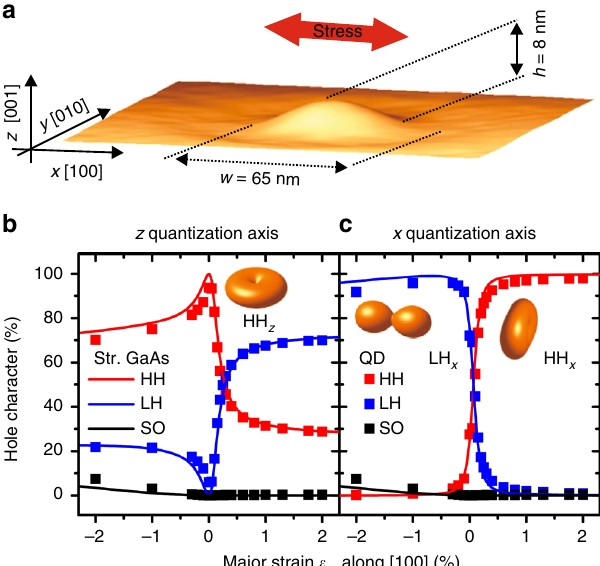
Fig. 1 Illustration of the concept used to rotate the natural quantization axis of an epitaxial QD. a 3D view of an AFM image of a GaAs QD embedded in AlGaAs matrix. b , c Calculated effect of uniaxial stress along the [100] crystal direction on the degree of mixing of the topmost VB using the z and x quantization axis, for bulk GaAs subject to a fi xed in-plane biaxial compression with σ xx = σ yy = − 120 MPa (solid curves) and for the experimentally studied QDs (symbols). The plots illustrate the importance of the choice of the quantization axis when discussing VB mixing and show that the natural quantization axis of the chosen QDs can be fl ipped with moderate strains. Insets: Angular dependence of the probability density distribution of the Bloch wavefunctions of the topmost VB states at the Γ point showing the conversion of a HH z state into a HH x (LH x ) state under tension